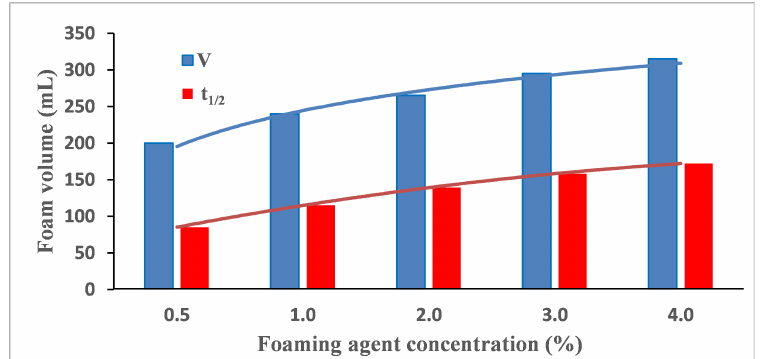
Figure 3. Foaming volume and half-life of different concentrations of foaming agent.